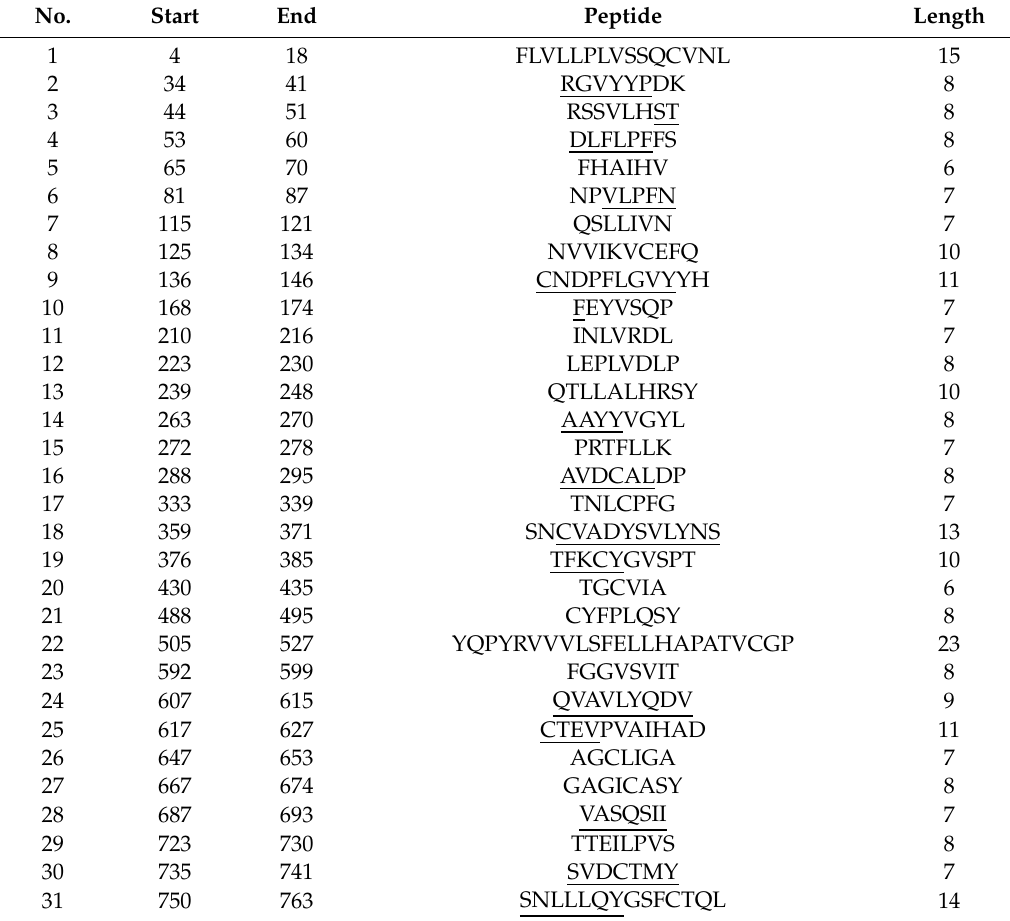
Table 4. Predicted antigenic B-cell epitopes of SARS-CoV-2 spike